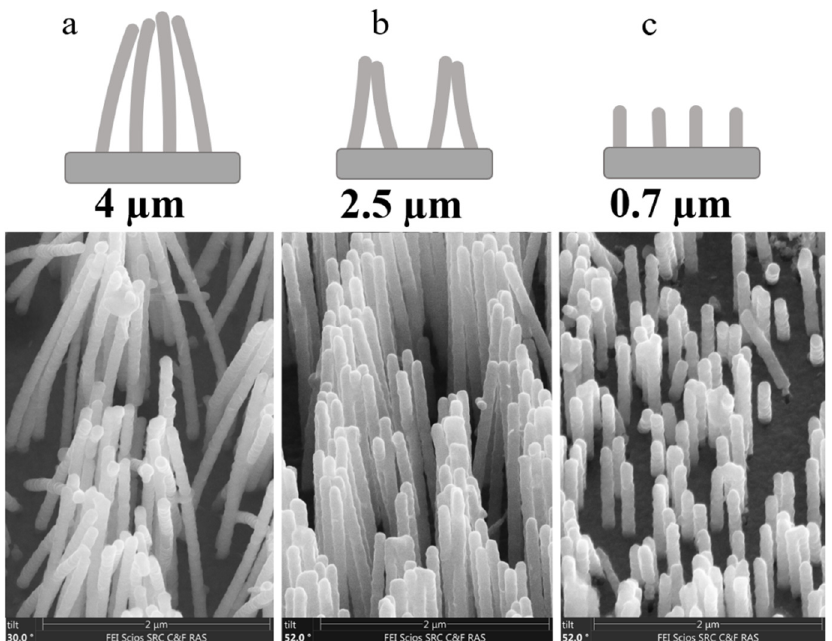
Figure 7. Feature of the leaning of the 100 nm diameter Ag ‐ NWs, depending on their length. ( a ) shows that sufficiently long NWs form the bundle, while so ‐ called “middle ‐ sized” NWs form the point contact between their tips ( b ). NWs with the length of fewer than 1 μ m are not leaning due to its short length ( c ).